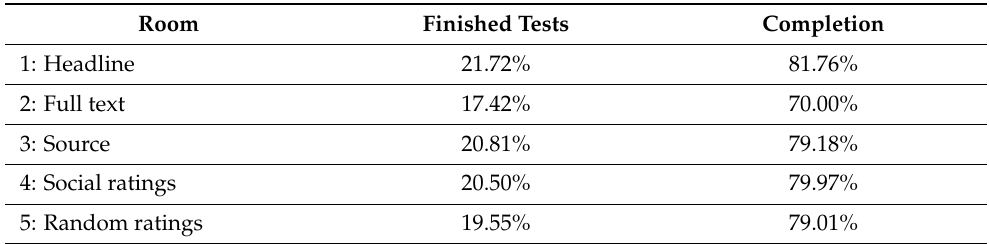
Table 1. Tests completion percentages grouped by rooms. Users are distributed randomly following an uniform distribution in the five rooms, but complete tests in Room 2 are only 17.42% of the total. Users in Room 2 left the test unfinished almost 10% more times than users in other